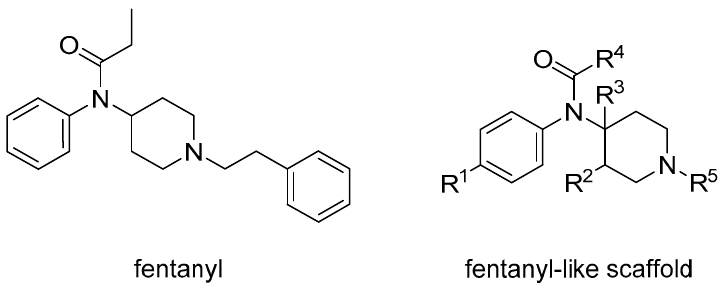
Figure 1. Structure of fentanyl and fentanyl-like compounds.